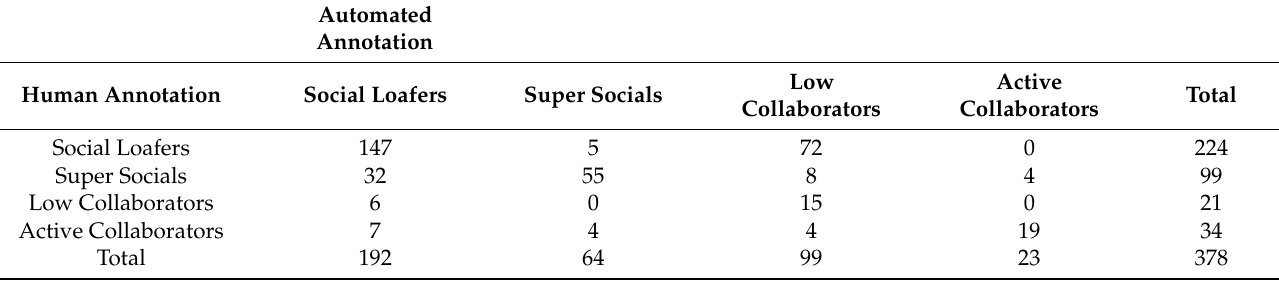
Table 6. Comparison of cluster analysis results based on counts of participants in each cluster across annotation